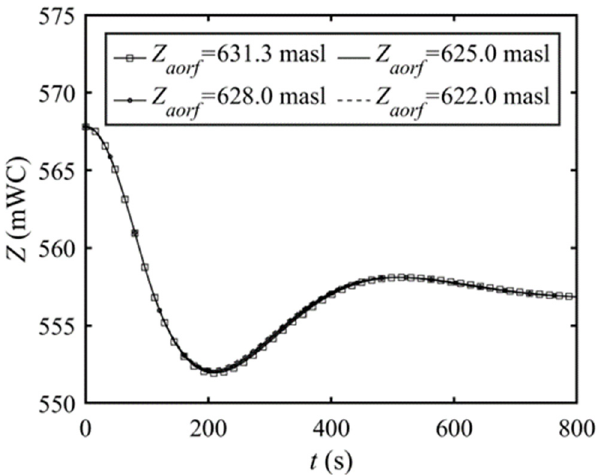
Figure 8. Simultaneous start—STWL of the semi-pneumatic throttled chamber surge tank for various vertical positions of the aeration orifice.